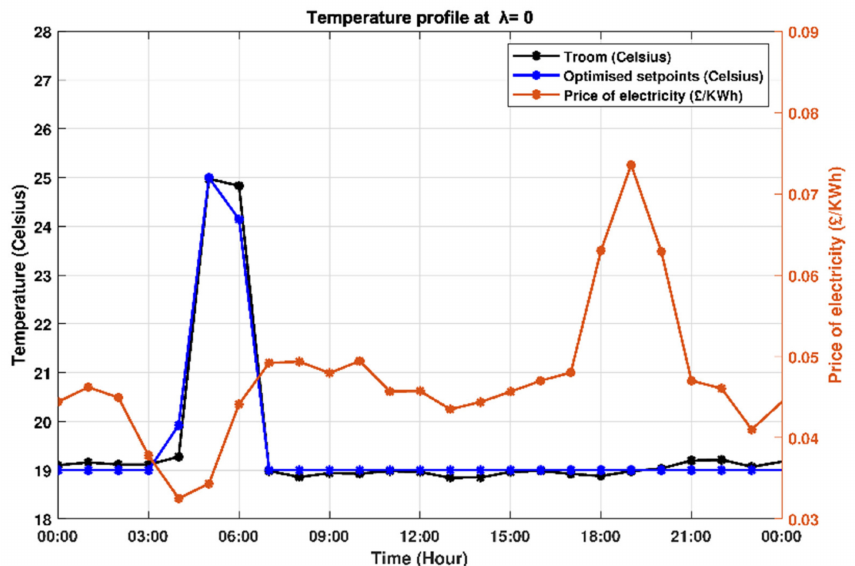
Figure 4. Room temperature and MPC-generated setpoints over 24 h when λ is set to 0—indicating maximum preference for energy saving.